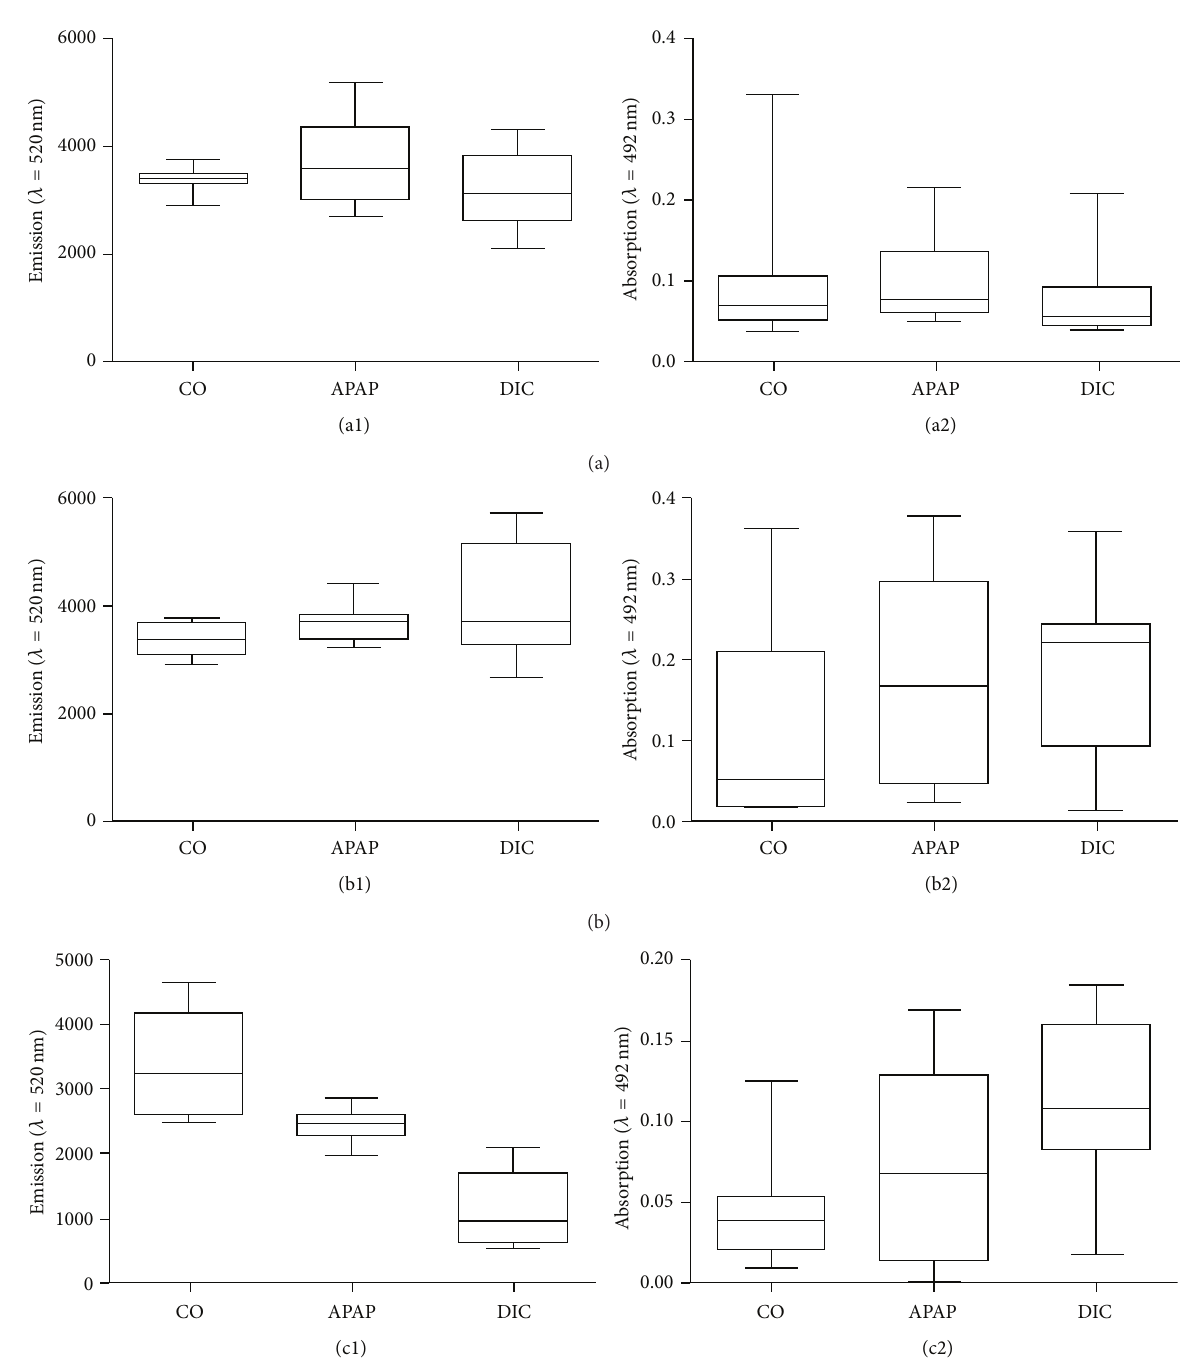
Figure 5: KC activation with supernatants of PHH previously incubated with subtoxic concentrations of hepatotoxic drugs . PHH of three donors (A, B, and C, see Table 1) were treated with 100 𝜇 M acetaminophen (APAP) or 100 𝜇 M diclofenac (DIC) for 1 h. The supernatants were used to stimulate KC from the same donor for 2 h. The intracellular ROI formation ((a1), (b1), and (c1)) was investigated by the DCF assay and the KC activity ((a2), (b2), and (c2)) was determined by the XTT assay. Data are shown as box plots, representing the median, the interquartile range, and minimum and maximum values, 𝑛 = 4